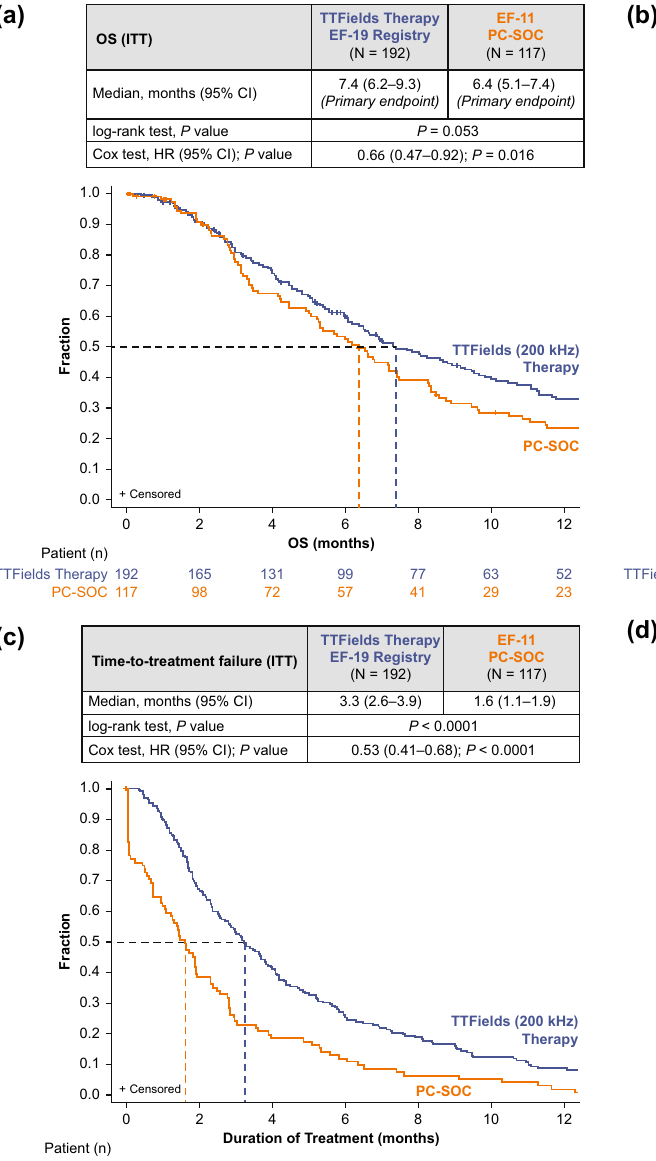
In the TTFields therapy arm, patients whose tumors were MGMT promoter methylation status positive had a numerically extended OS (95% CI) of 10 months (6.0–13.9) vs 6.5 months (4.5–7.4) in patients with tumor-negative status; HR (95% CI) was 0.77 (0.46–1.30), ( P = 0.322, log-rank test ; Fig. 3A). Patients with IDH1 gene mutation in the ITT population demonstrated a trend toward longer OS (95% CI) of 14.4 months (4.5–not reached) vs 6.5 months (5.1–8.0) in patients with wild-type IDH1 gene status; HR (95% CI) of 0.52 (0.25–1.05; P = 0.065 Fig. 3B). These tumor biomarker subgroup assessments ( IDH1 and MGMT ) were not performed in the EF-11 study (non-comparable). In the TTFields arm, patients who were treated for ≥ 18 h/day (≥ 75% daily usage; monthly average in the first 6 months of treatment) in the ITT population had a longer OS (95% CI) of 9.8 months (6.5–13.9) vs 6.7 months (4.8–8.9) for < 18 h/day